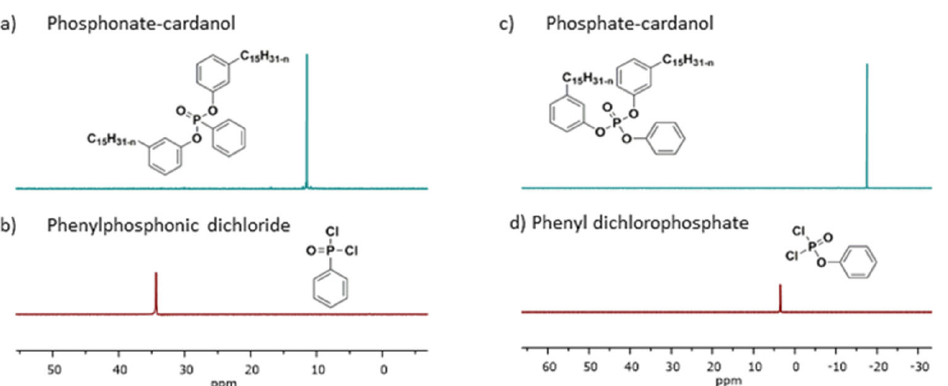
Figure 2. 31 P NMR spectra of ( a ) phosphonate ‐ and ( b ) phosphate ‐ cardanol compounds and their ( c ) and ( d ) initial phosphorylated reagents.